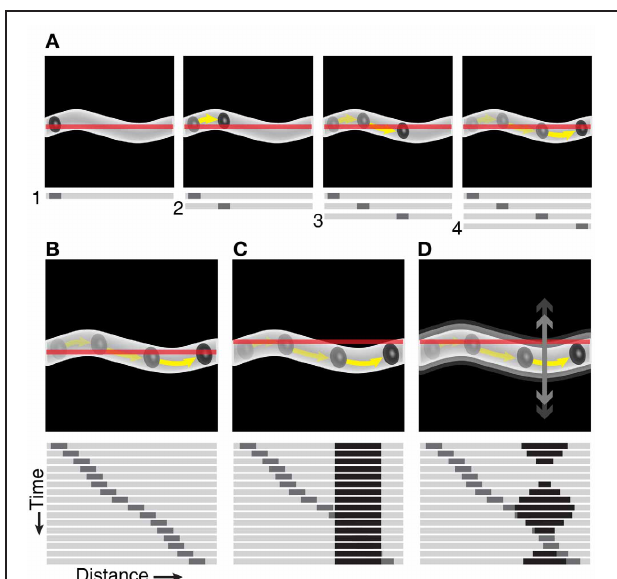
FIGURE 1 | Schematic of using a line-scan protocol to create space-time images under ideal recording conditions and when artifacts are present. (A) Full-frame image showing an RBC traveling inside a vessel. The line-scan path is represented as a red line (in top panels) and a stack of sequential line-scans shows the RBC at four different locations in the vessel (bottom panels). (B) Repeated line-scans through the identical location in the vessel (top panel) results in a space-time image that has a diagonal RBC streak (bottom panel). (C) A line-scan path that goes outside the vessel (top panel) results in a time-invariant artifact, represented as a black vertical band in the line-scan image (bottom panel). (D) Movement of the vessel relative to the line-scan path (top panel) results in a time-varying artifact, represented by the variable width of the black band in the line-scan image (bottom